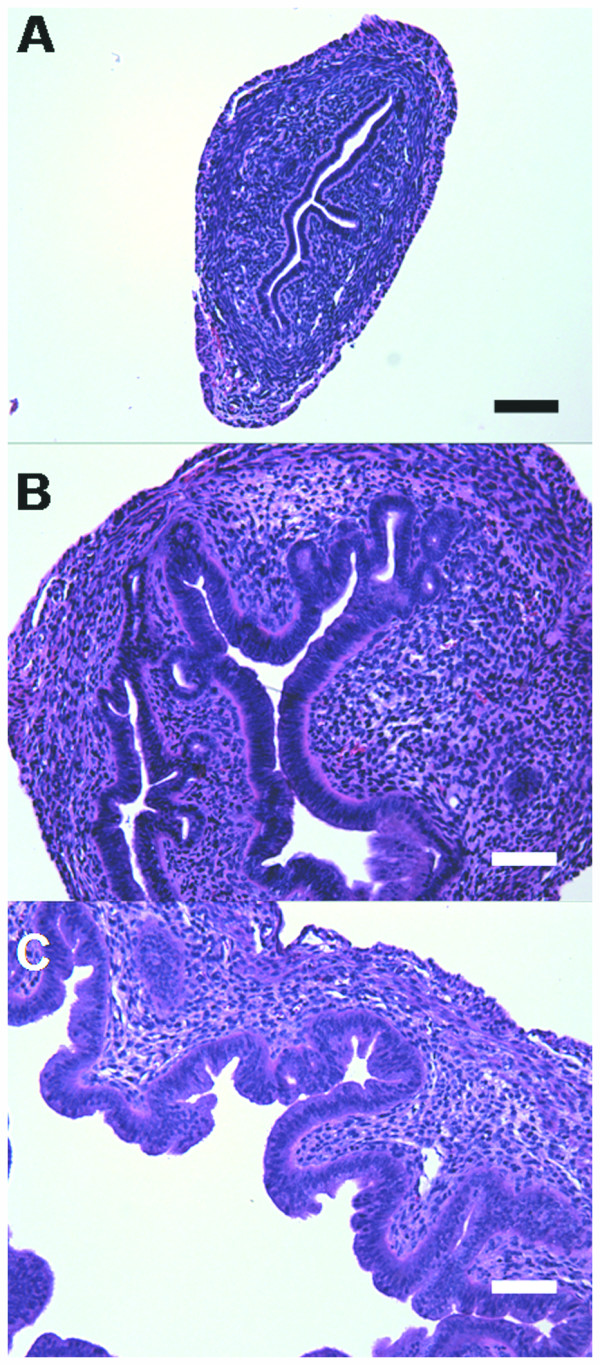
Uterine histology. Hematoxylin and eosin stained sections of uterine tissue at 100× magnification after three daily doses of A) sesame oil, B) 1 mg/kg TAM and C) 100 μg/kg EE. TAM and EE treatment induced increases in luminal epithelial cell height. Luminal circumference is increased to a greater degree by EE than TAM. Bars represent 20 μm.